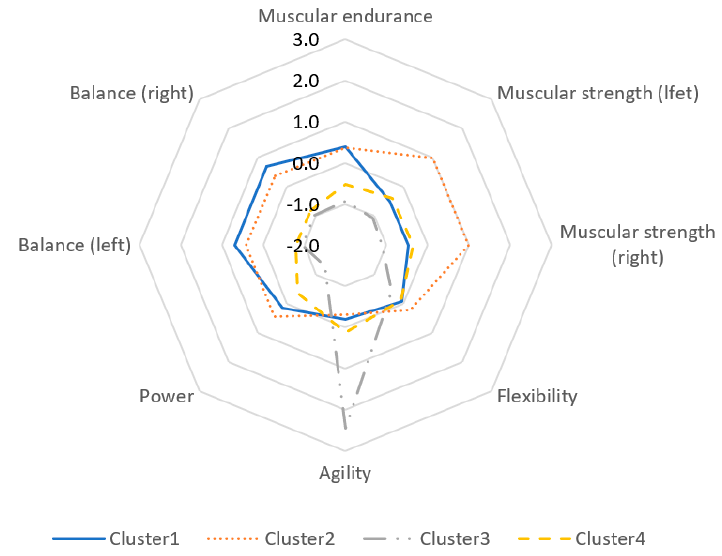
Figure 1. Physical fitness characteristics of each cluster.